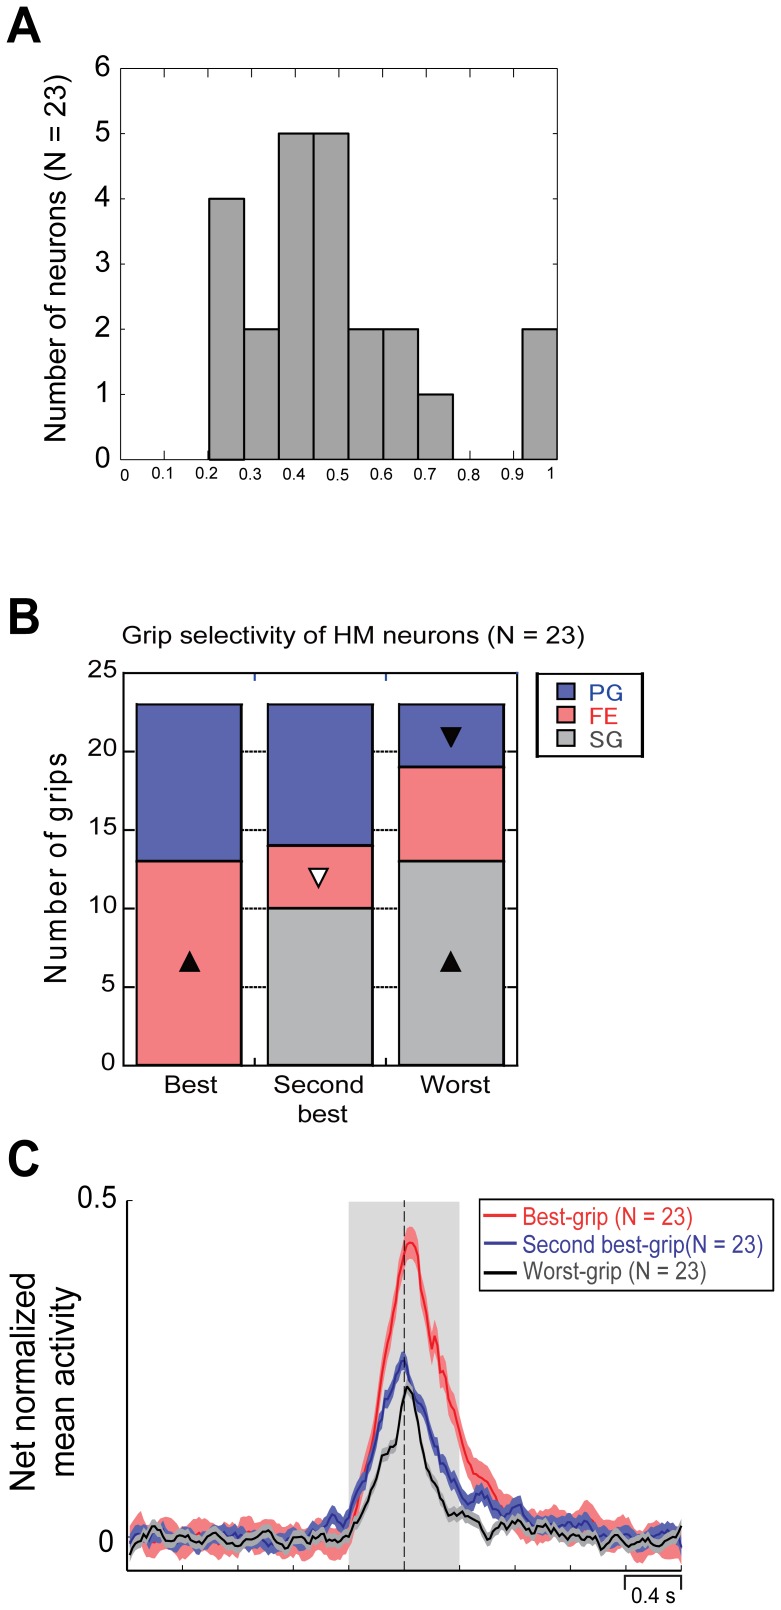
Grip-selectivity of hand-manipulation related neurons.(A) Distribution of grip-preference index values. (B) Proportion of each grip in three grip selective categories (Best-, Second best- and Worst-grip). Triangles (▴ or △) indicate that the actual measurement of grip is significantly larger than expected values. Inverse triangles (▾ or ▽) indicate the actual measurement of grip is significantly smaller than expected values. Colors of triangles correspond to level of α, namely black corresponds to p<.01, white corresponds to p<.05. (C) Temporal profile of the net normalized mean activity of each grip categories. Conventions as in Figure3.